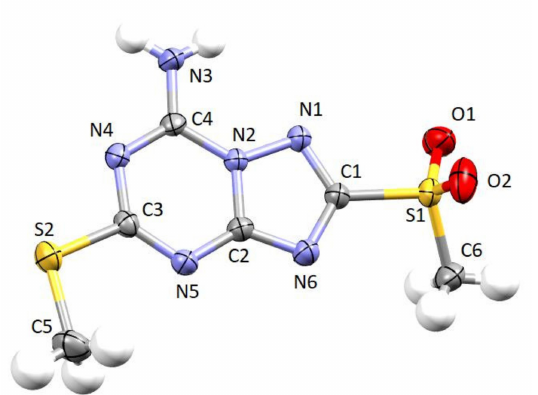
Figure 3. Ortep style view of compound 17 . Ellipsoids are shown at 50% probability level. Selected bond distances (Å) and angles ( ◦ ): C1-N1 1.323(2), C1-N6 1.353(2), C1-S1 1.7794(16), C2-N6 1.332(2), C2-N5 1.344(2), C2-N2 1.3728(19), C3-N5 1.317(2), C3-N4 1.365(2), C3-S2 1.7480(16), C4-N3